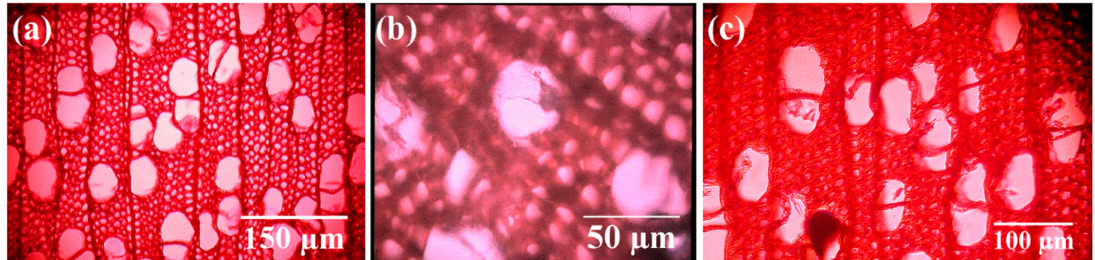
Figure 1. Optical micrographs of ( a ) undecayed control wood sample; ( b ) decayed control wood sample; and ( c ) sample treated with silver nanoparticles (AgNPs) (20 ppm), subjected to the action of T. versicolor for 16